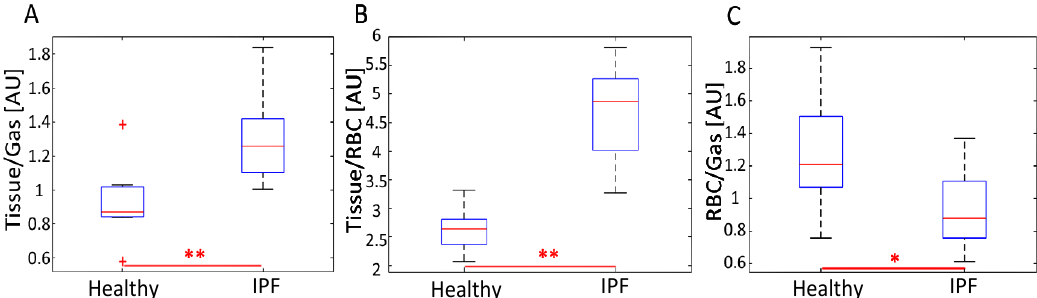
Figure 3. Distribution of average ( A ) Tissue/Gas, ( B ) Tissue/RBC, and ( C ) RBC/Gas ratios for healthy and IPF subjects. IPF subjects typically had a significantly increased average Tissue/Gas and Tissue/RBC ratio ( p < 0.01) and a decreased average RBC/Gas ratio ( p < 0.05). The distribution of average Tissue/RBC ratios was larger in IPF than healthy subjects. The uppermost outlier in ( A ) represents subject H8. * represents p < 0.05 and ** represents p < 0.01.